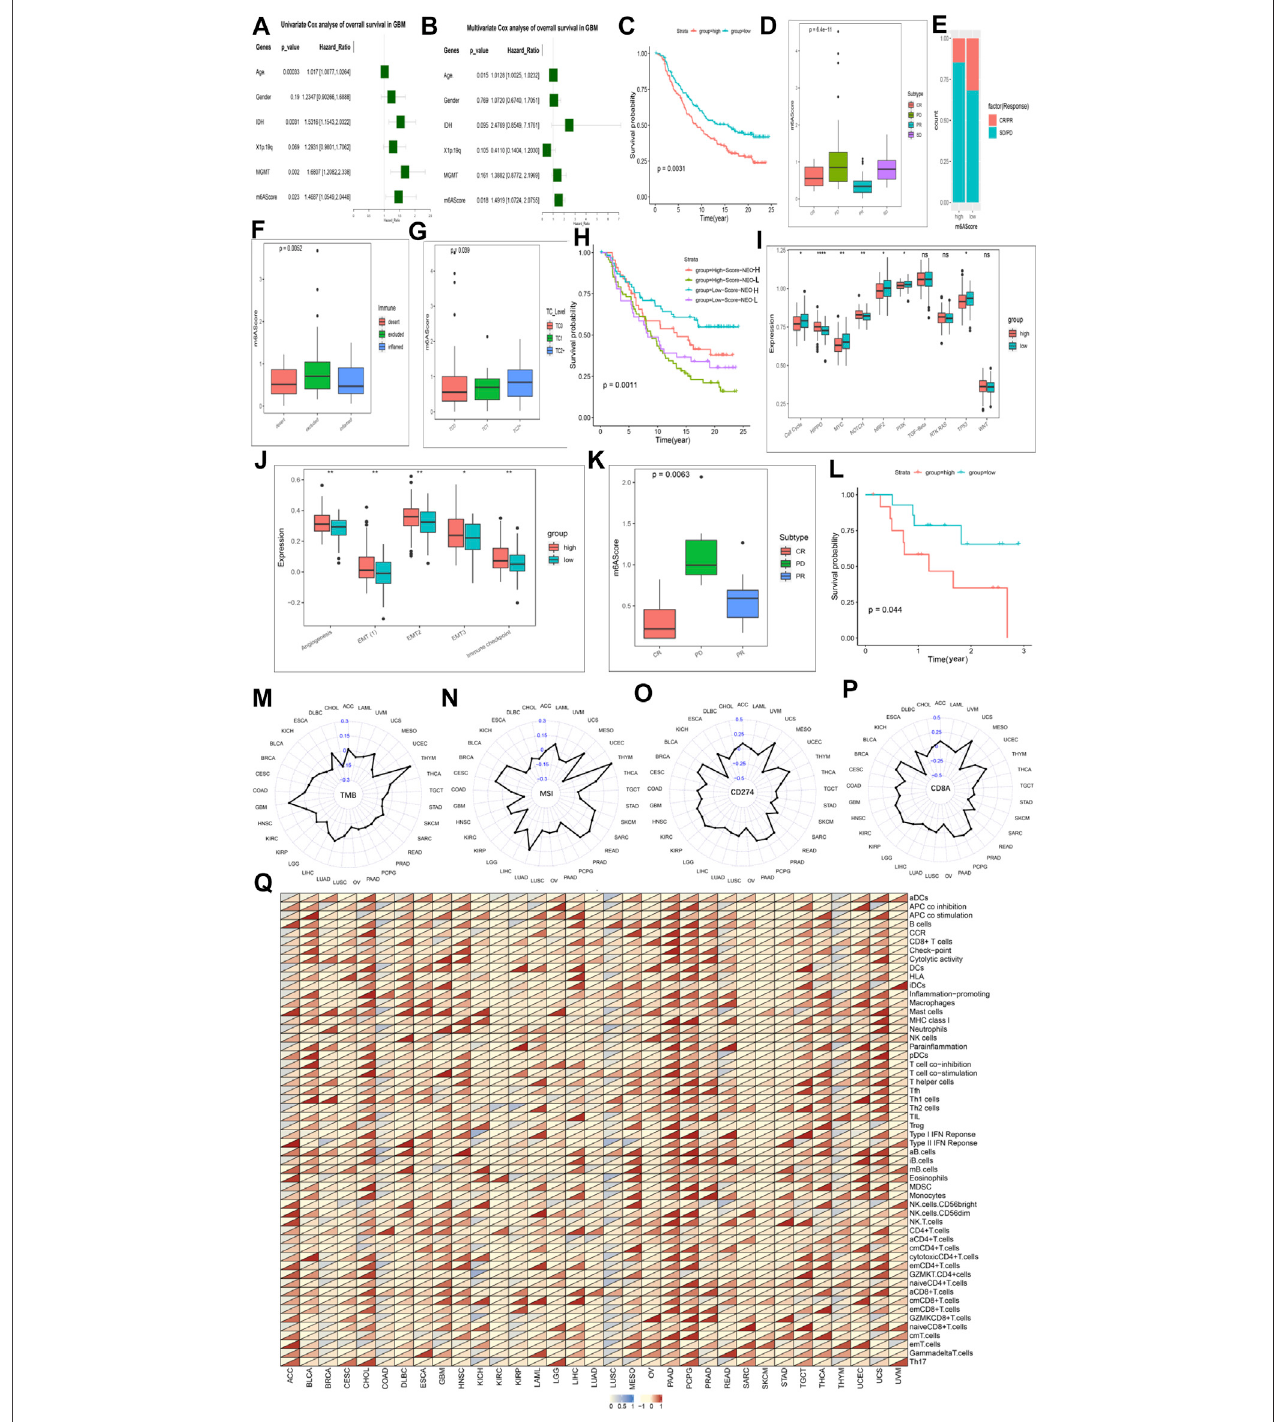
FIGURE 6 | The role of the m6AScore in anti-PD-1/L1 immunotherapy and pan-cancer. Cox regression analyses (A,B) . univariate (A) and multivariate Cox regression analyses (B) of the association between clinicopathological factors (including the m6AScore) and progression-free interval of patients in the TCGA-GBM combined CGGA-GBM cohort. (C) Survival analyses for the low-m6AScore and high-m6AScore subgroups in the IMvigor210CoreBiologies cohort (treated with the anti-PD-L1 agent, Atezolizumab) using Kaplan – Meier in Log-rank test. (D) The Kruskal – Wallis test detected differences in m6AScore between patients with differentclinicalresponsesintheIMvigor210CoreBiologiescohort. (E) TheproportionofpatientsintheIMvigor210CoreBiologiescohortwithclinicalresponseinthelow- m6AScore or high-m6AScore subgroups. (F,G) Kruskal – Wallis test detected differences in m6AScore between immunophenotypes (F) , tumor cells (TC, (G) ) in the